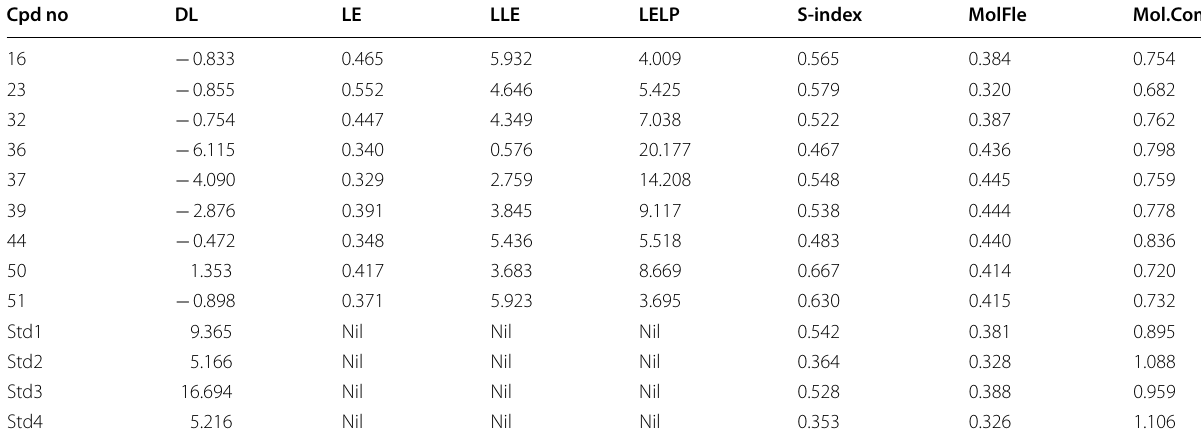
DL, drug-likeness; LE, ligand efficiency; LLE, ligand lipophilic efficiency; LELP, ligand efficiency dependent lipophilicity; S-index, shape index; MolFex, molecular flexibility; Mol.com, molecular complexity;Std1, ampicillin; Std2, oxytetracycline; Std3, chlortetracycline; Std4, ceftriaxone